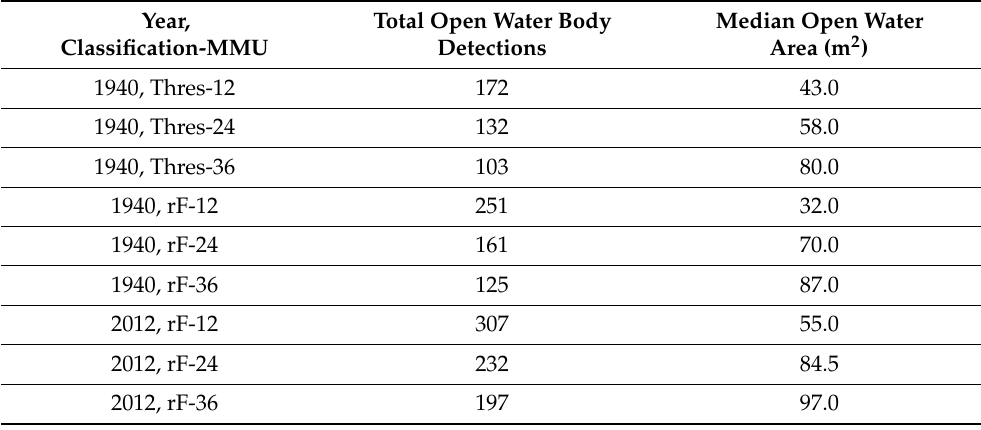
Table 4. Median open water body detection number and median size in square meters (m 2 ) for 1940 and 2012 wetland maps across classification methods and MMUs of 12, 24, and 36 m 2 . Thres = threshold classifications; rF = random forest